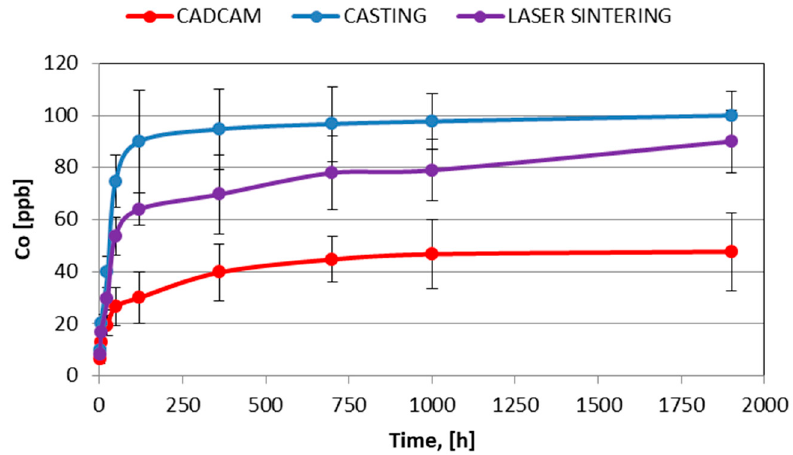
Figure 7. Co-release for different test times and types of manufacturing methods.